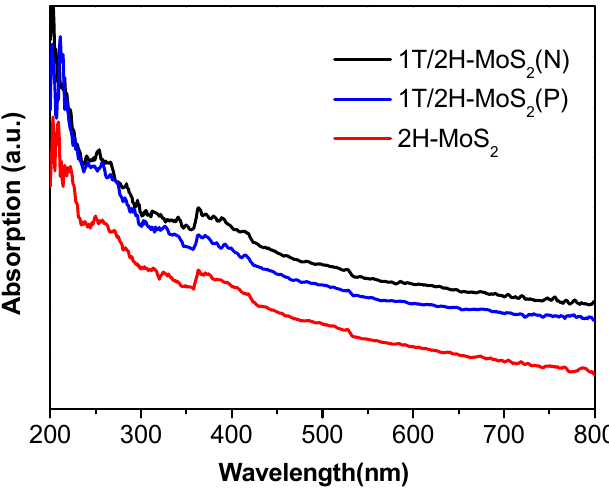
/ 2H-MoS 2 (P), 2H-MoS 2 , and 1T 2